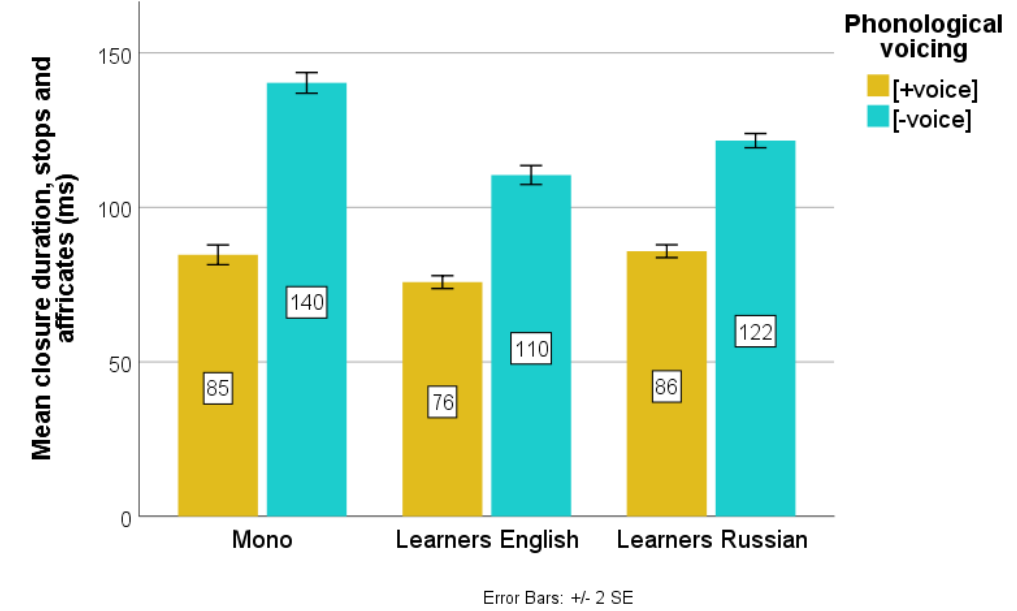
Figure 16. Mean voiced and voiceless closure for final stops and affricates in monolingual controls’ and learners’ English productions; learners’ Russian productions are provided for comparison.